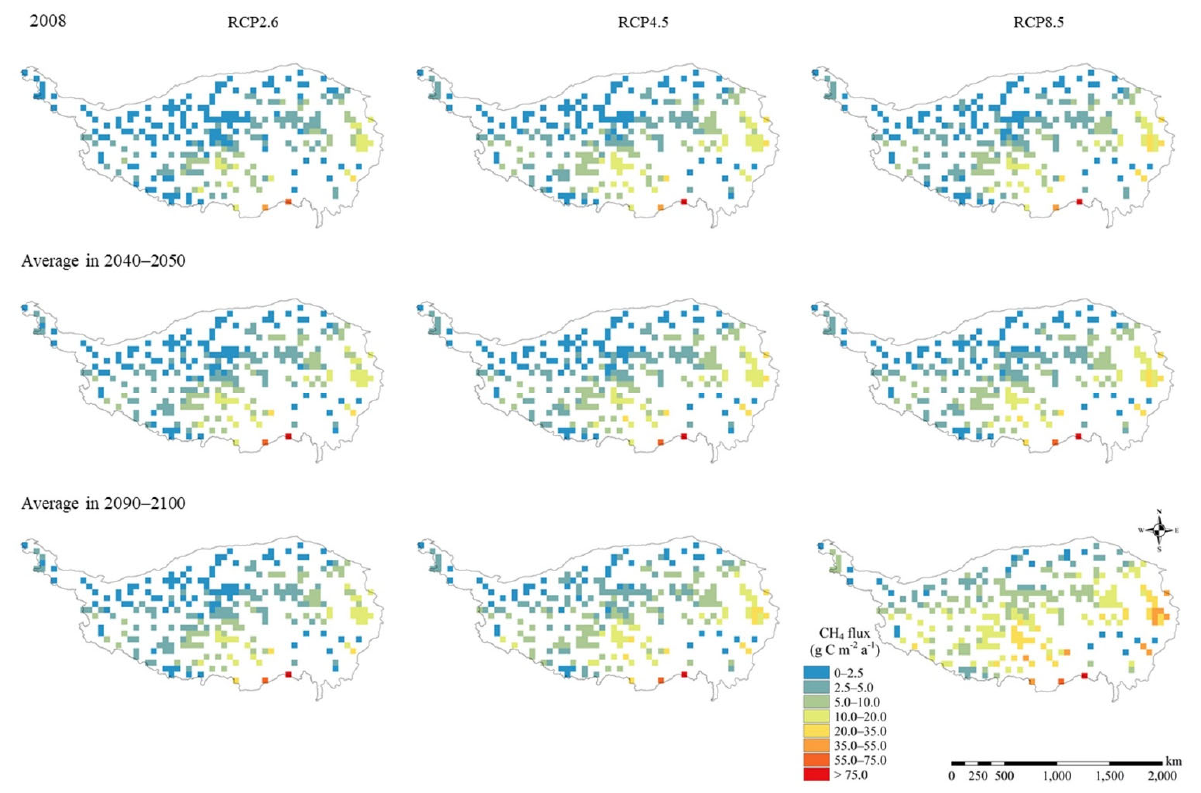
Figure 4. Spatial distributions of CH 4 emissions from wetlands on the Qinghai–Tibet Plateau for three RCPs and three time periods.